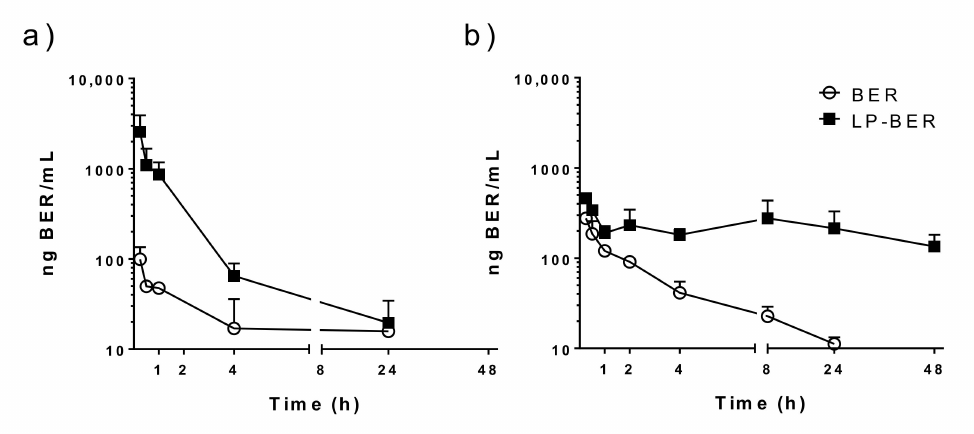
Figure 3. Plasma concentration-time curve of BER in mice after (a) i.v. or ( b ) i.p. administration of free BER and LP-BER at ( a ) 7.5 or (b) 15 mg / kg. Data represents mean ± SD, n = 3 mice per group.